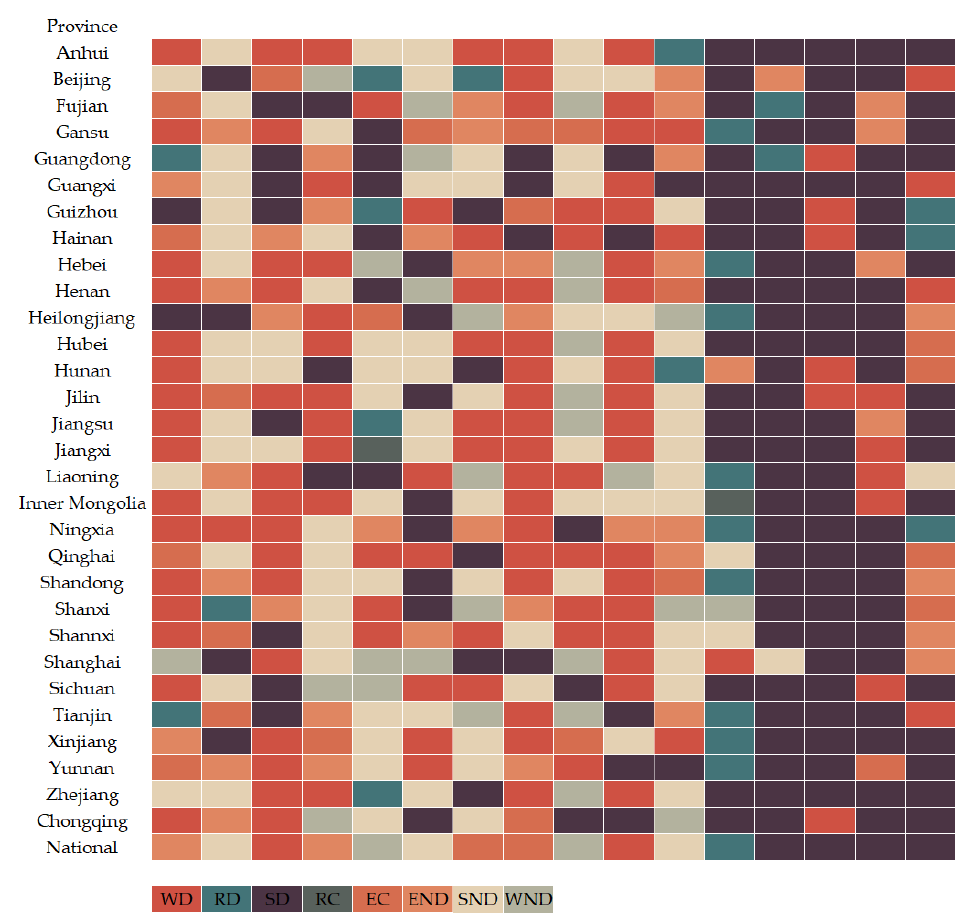
Figure 5. Decoupling status of nations and provinces from 2004 to 2019 (the first column is 2004, and so on, the last column is 2019). Table 4. The result of ∆ EPI, ∆ EG, and λ for the sample city Beijing.